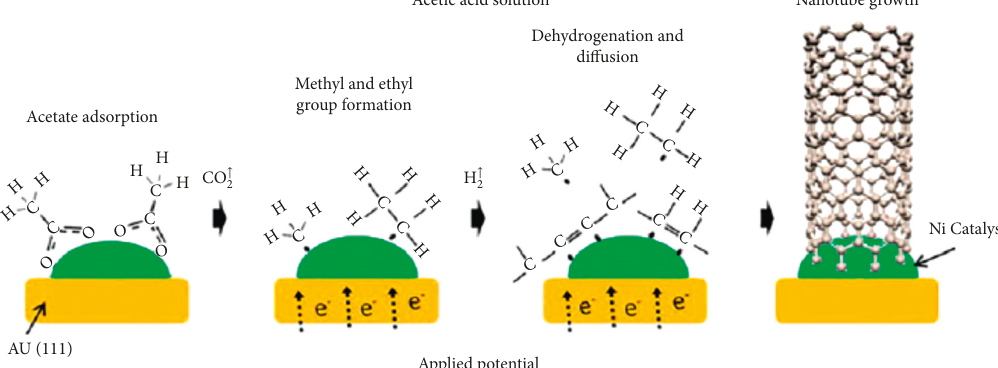
Figure 9: Proposed mechanism for SWCNT growth on Au supporting Ni nanocatalyst by the electrochemical process [64].